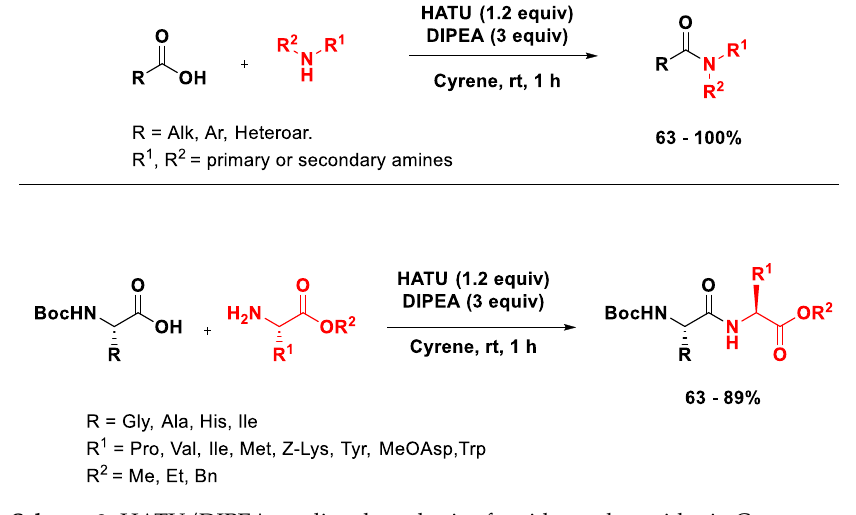
Scheme 3. HATU/DIPEA-mediated synthesis of amides and peptides in Cyrene.